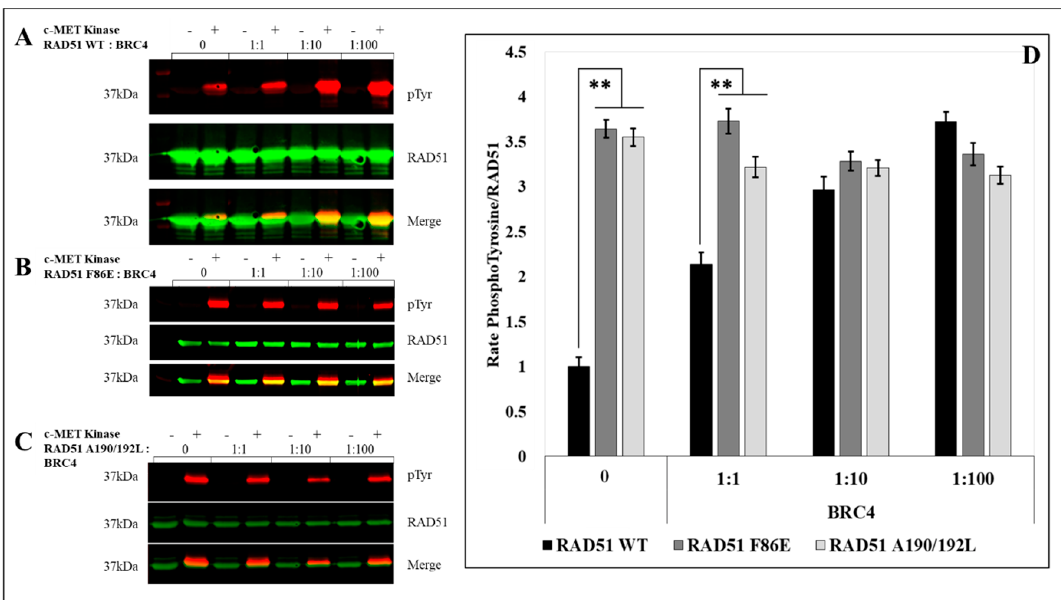
Figure 5. c-MET-mediated RAD51 phosphorylation is related to its oligomeric state. ( A ) The RAD51 WT protein (10 µM) and all non-polymerizable mutants of RAD51: ( B ) F86E and ( C ) A190/192L were purified and incubated with ATP (2 mM), with or without kinase-active c-MET (0.1 µM), and an increasing concentration of BRC4 peptide. Then the proteins were separated by SDS-PAGE 12% gel and analyzed by western blot using anti-RAD51 (green) and anti-phosphotyrosine (red) antibodies. The signals were quantified by Odyssey scanner and compared with the signal from RAD51 WT. ( D ) The graph represents the phosphorylation rate of each mutant compared to the wild protein following the quantification of blots from three independent experiments ( n = 3; errors bars: s.d.; ** p < 0.01).